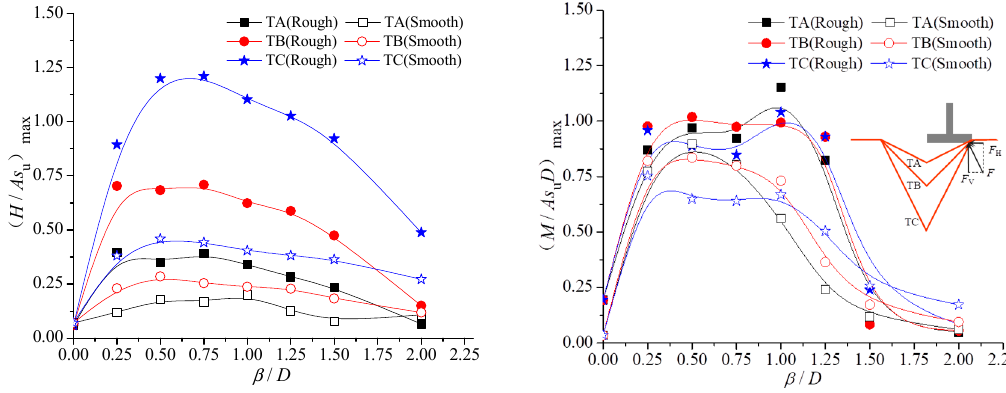
Figure 14. Maximum normalized H and M values against eccentricity ratio (flat base footing).